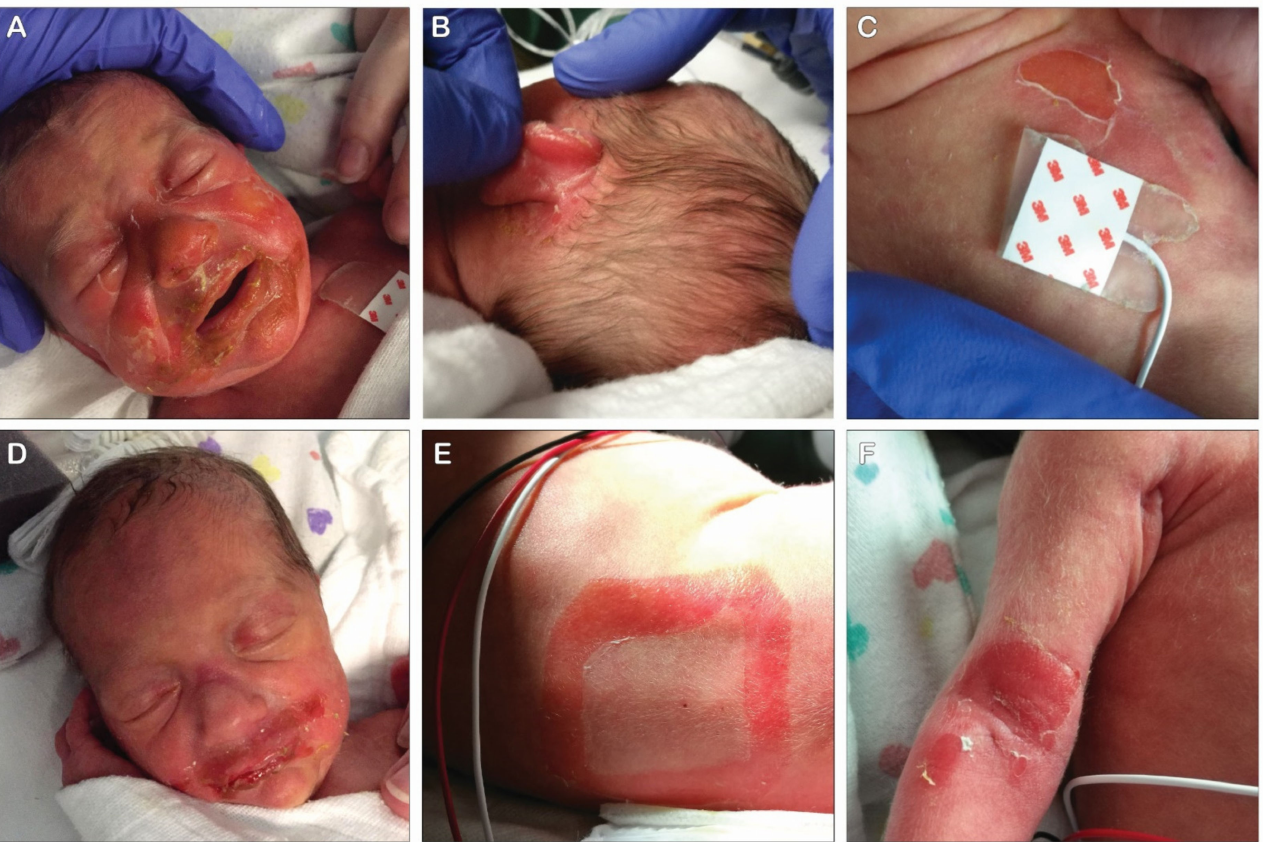
Figure 1. Skin lesions caused by S. aureus infection. Skin lesions were more widespread in twin I (panel ( A – C )) as compared to twin II (panel ( D – F )). In twin I, desquamation most severely affected the face ( A ), as well as friction areas such as ears ( B ) and inguinal folds, and skin exposed to adhesives sch as monitor electrodes on the chest ( C ). In twin II, desquamation was limited to sites exposed to adhesives on the face ( D ), back ( E ), and elbow fold ( F ). (Of note: written consent was obtained from the parents to publish these